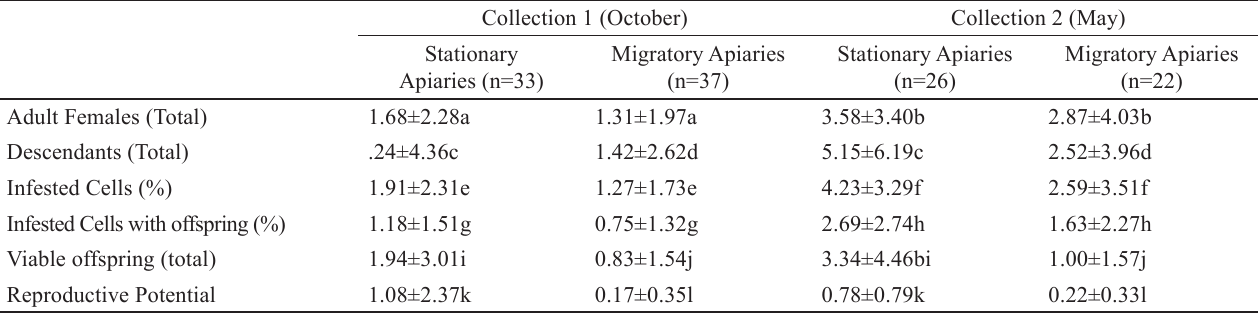
Table 2. Average number of adult females, descendants, infested brood cells (%), infested cells with descendants (%), total viable offspring and reproductive potential of the mite Varroa destructor in brood combs, in two collections, in stationary and migratory apiaries. Means followed by different letters differ statistically (p< 0.01).